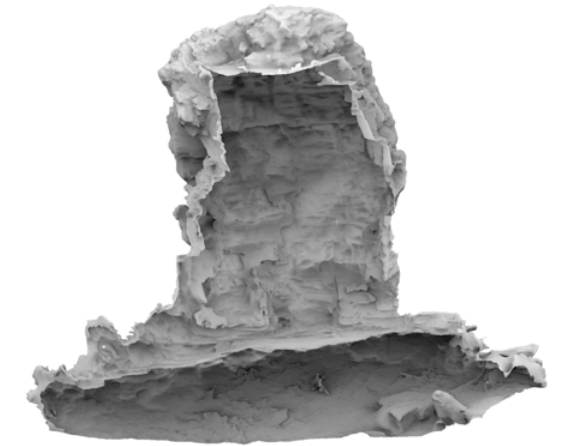
Figure 7. Meshed 3D model rendered with the "Portion of Visible Sky" plug-in from Cloudcompare